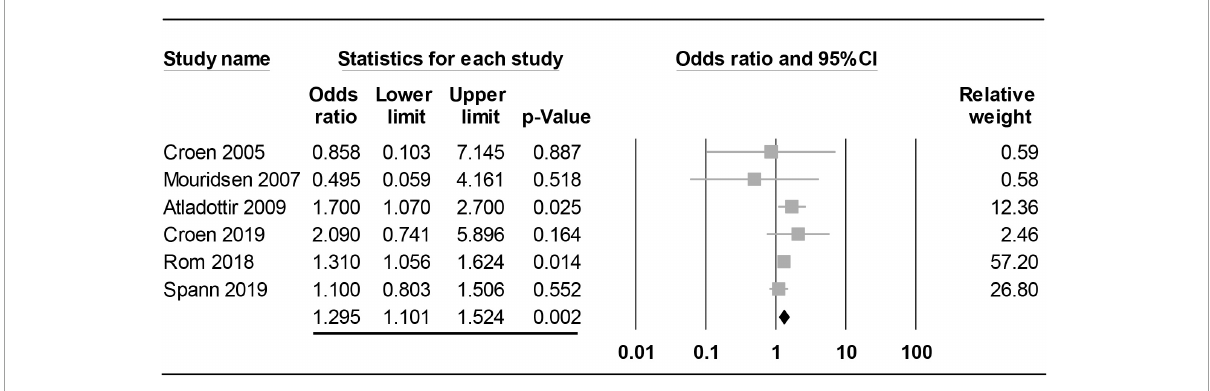
FIGURE7 Forest plot showing the correlation between maternal rheumatoid arthritis and risk of offspring autism spectrum disorder in studies from Western countries. CI, confidence interval.